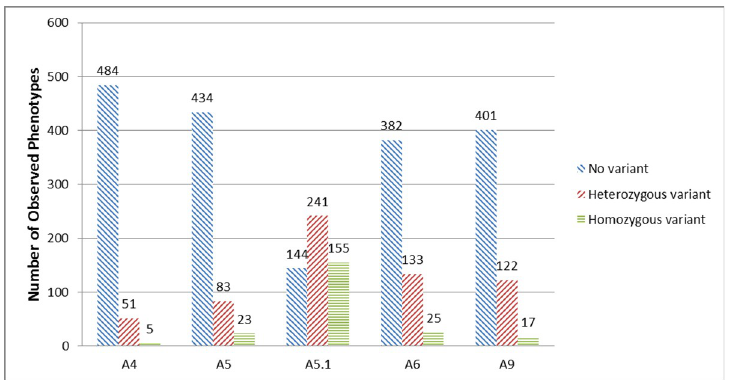
Fig 1. Distribution of MICA STR polymorphisms (A4, A5, A5.1, A6, A9). MICA genotypes were coded as not having the allele, being heterozygous or being homozygous for the allele if the participant possessed 0, 1 or 2 allele copies for the polymorphism, respectively (additive